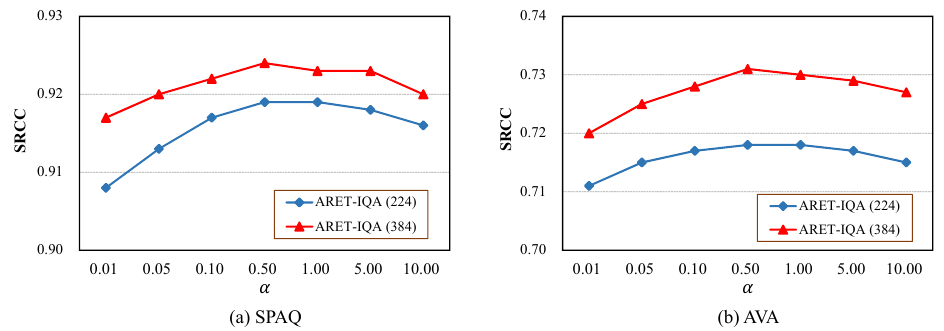
Figure 3. The efficacy of hyperparameter α in our model (ARET-IQA (224) and ARET-IQA (384)) on the SPAQ [27] and AVA [11]